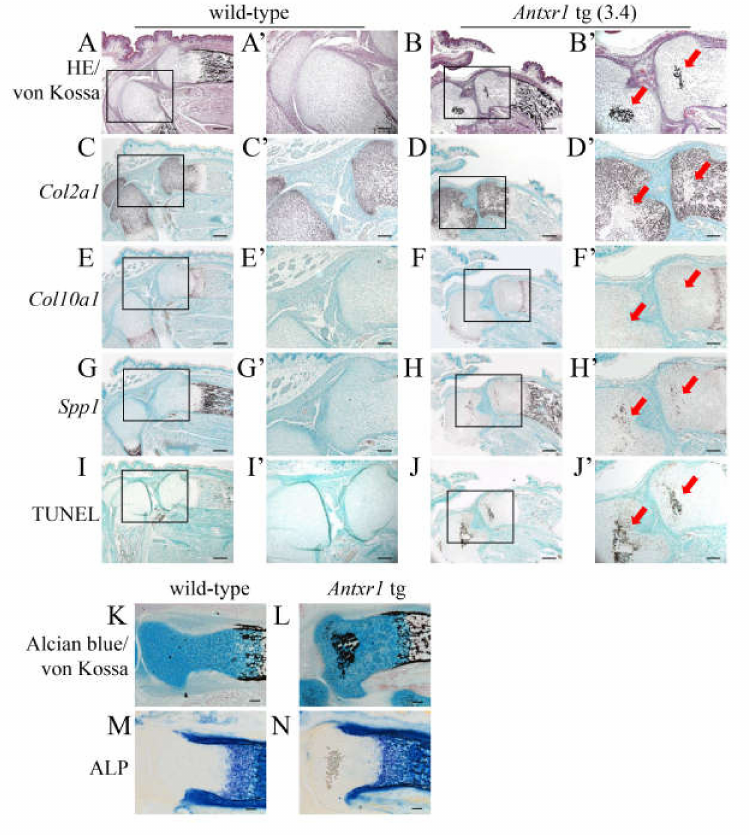
Figure 9. Chondrocyte maturation in the mineralized and apoptosis-enriched regions at E18.5: ( A – J ) Double-staining with H-E and von Kossa ( A , B ), in situ hybridization ( C – H ), and TUNEL staining ( I , J